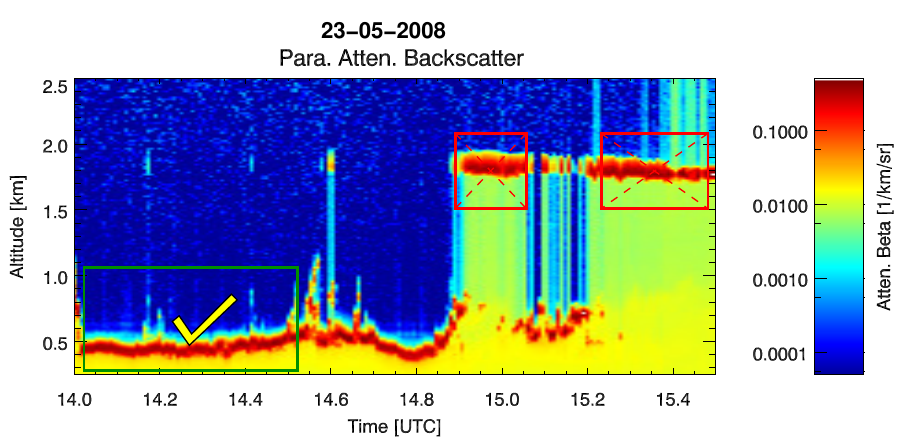
Figure 12. Illustration of the case selection criteria. Here all three of the boxed areas satisfy the conditions of being well-defined stratus water layers. However only the green outlined region appears to be connected to the surface. The data consist of measurements made using the ALS-450 system at